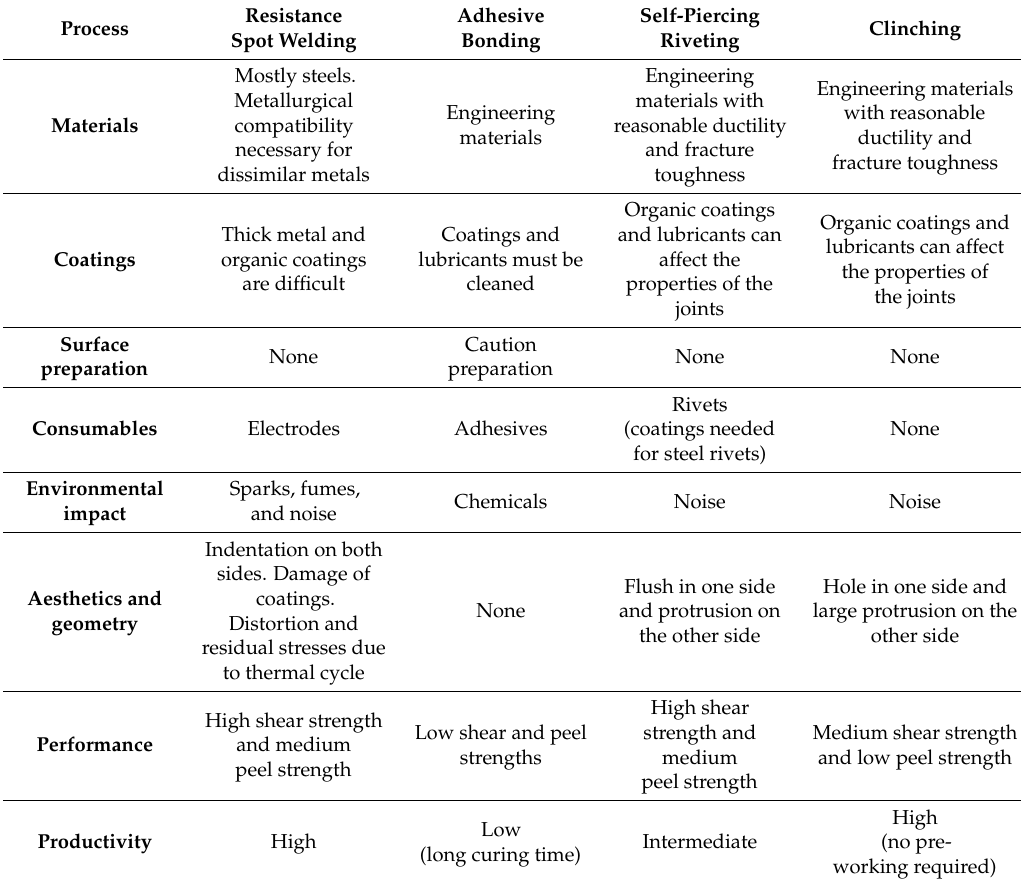
Table 1. Main characteristics of the fabrication processes that are commonly utilized to assemble thin-walled crash boxes with top-hat or double-hat shaped